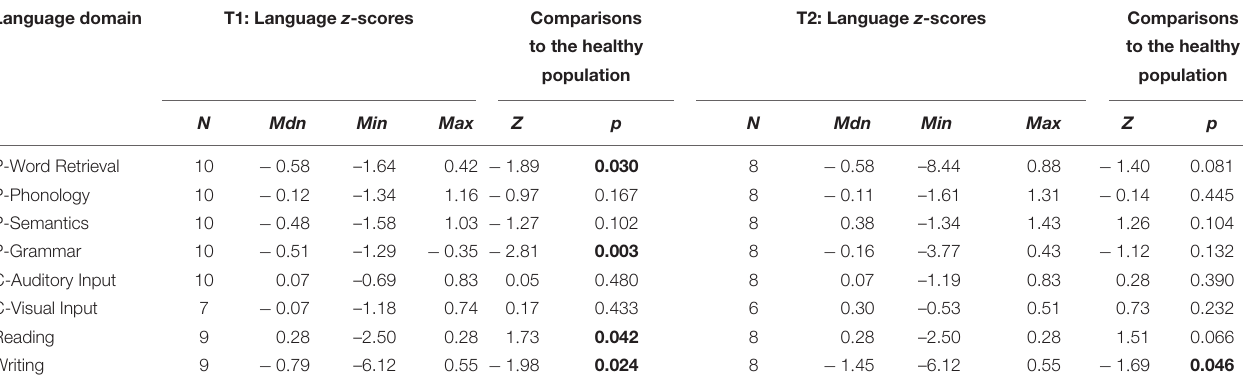
TABLE 5 | Language domain z -scores of meningioma patients at T1 and T2, including comparisons to normative data from a healthy population. Language domain